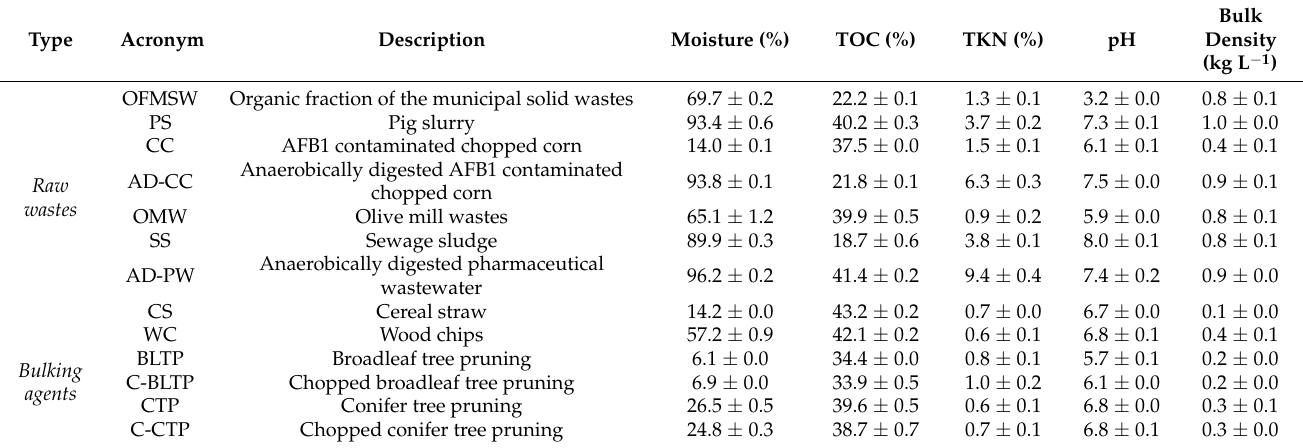
Table 1. Main characteristics of raw materials and bulking agents used in the composting